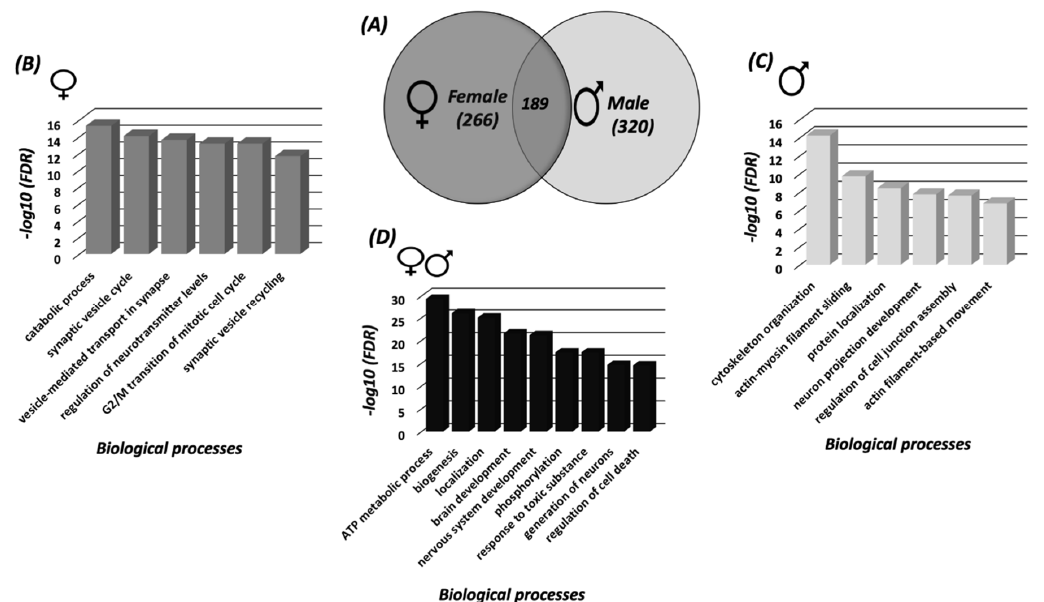
Figure 1. Systems biology analysis of the SNO proteins ( A ) Venn Diagram representing the SNO-proteins that were identified in female cortices and male cortices. BP analysis was conducted on the SNO proteins that are exclusive to ( B ) female cortices, ( C ) male cortices and ( D ) the shared SNO proteins. Each bar represents the − log10 of the False discovery rate (FDR) value.